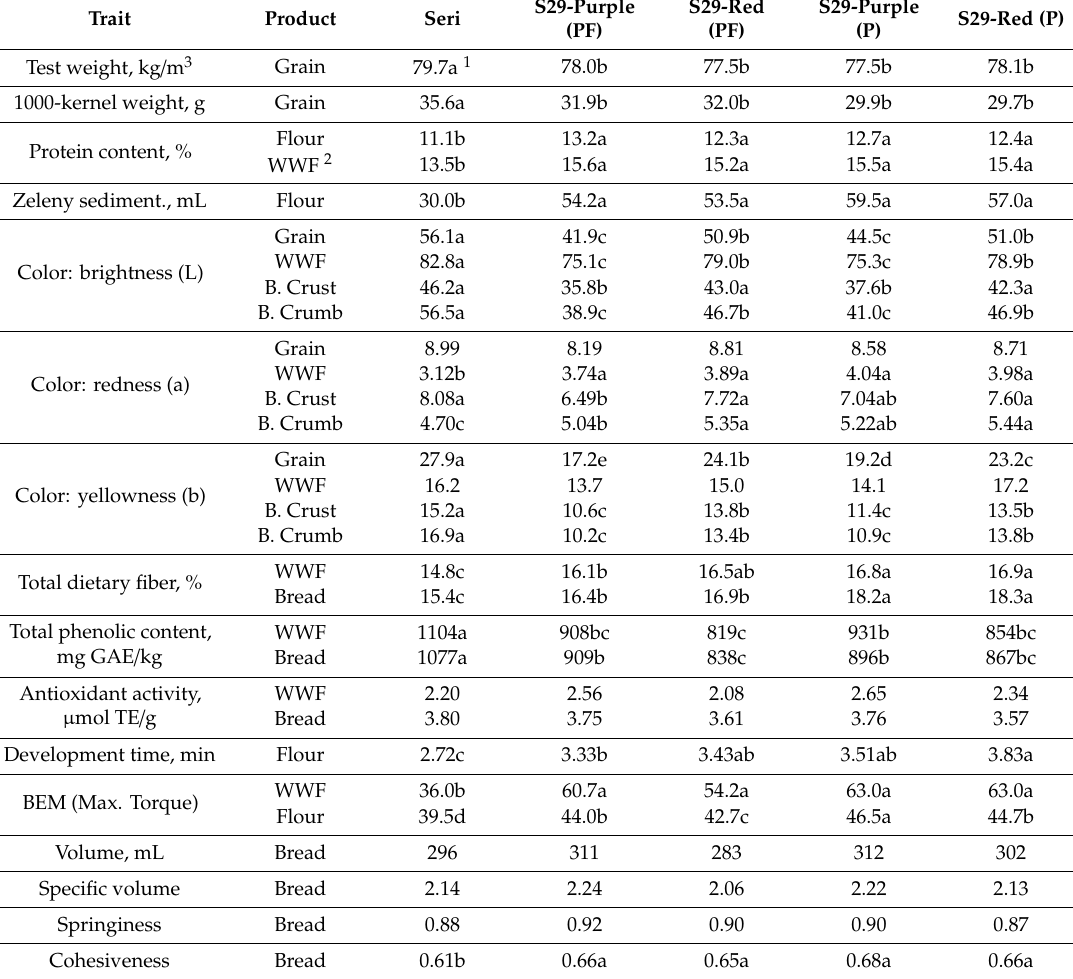
Table 6. Quality parameters in purple grain isogenic lines in Konya, Turkey, 2018.